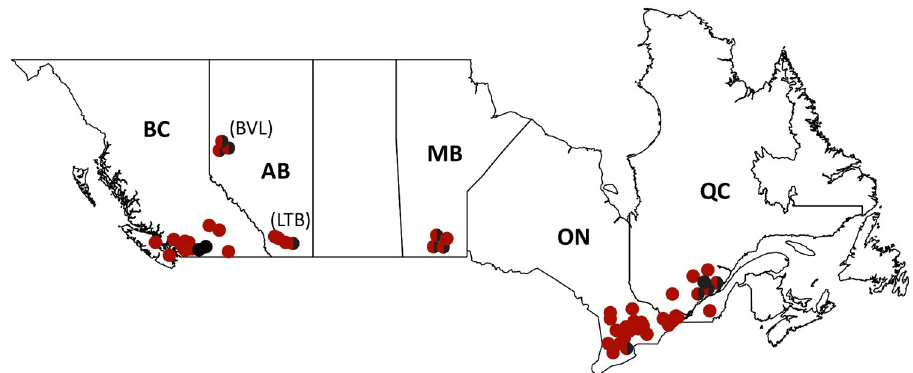
Fig 1. Map of Canadian provinces (territories not shown) illustrating the geographical distribution of the apiaries in the experimental year of 2016–2017 (red circles) and 2017–2018 (black circles). Red and black circles represent yards used in both experimental years. Participating provinces are identified with their two-letter abbreviations (BC = British Columbia, AB = Alberta, MB = Manitoba, ON = Ontario, QC = Quebec). The two distinct locations sampled in the province of Alberta are identified by three-letter abbreviations (BVL = Beaverlodge, LTB = Lethbridge).